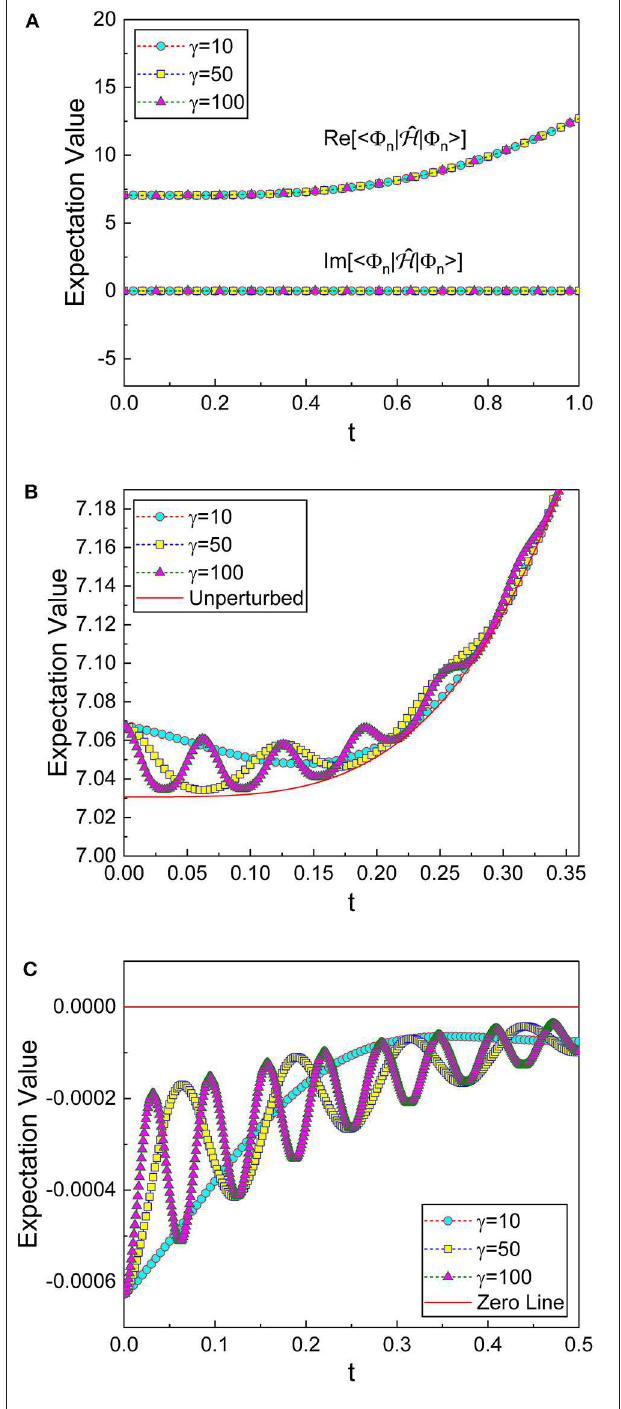
FIGURE 3 | (A) The time evolutions of the real and the imaginary parts of the expectation values, Equation (35), for the system described in Equations h (43)–(47) for three different values of γ . The parameters are chosen as 1, = ¯ ω 0 ρ 2,0 1, m 0 1, n 10, ρ 1,0 1, α 1, c 1, d 0.5, and = = = = = = = = ǫ 0.001. (B) Enlargement of the real parts in (A) . The reference solid red line = is the expectation value of the unperturbed Hamiltonian, given in Equation (17). (C) Enlargement of the imaginary parts in (A) . The reference solid red line indicates zero of the vertical